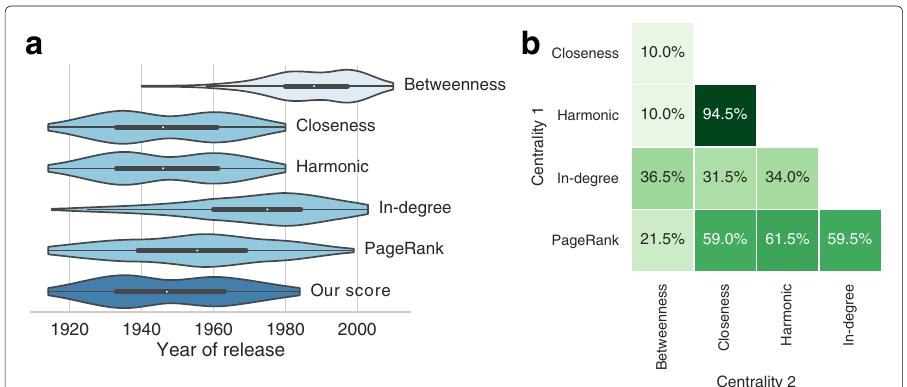
Fig. 3 Statistics on centrality scores applied to our dataset. a Year of release of top 200 films according to different ranking methods, b Percentage of top 200 movies in common between two ranking